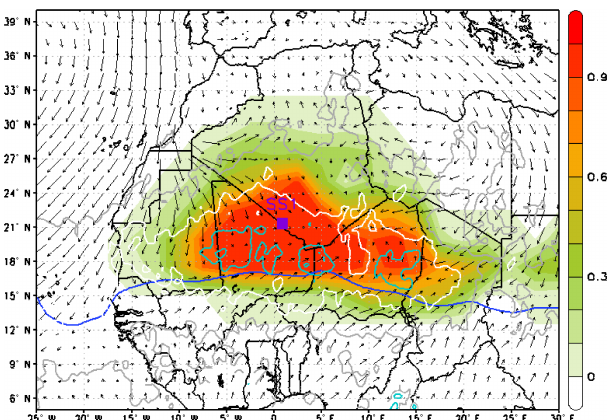
Figure 1. Climatological state of the Saharan heat low region (mean of June, 1979–2013): SHL location, low-level circulation, and dust load. Shaded: the mean position of heat low region (occurrence fre- quency of 90% of low-level atmospheric thickness); arrows: mean 925hPa wind; blue line: the mean position of the intertropical dis- continuity from ERA-Interim reanalysis data and aerosol optical depth (AOD) from Multi-angle Imaging Spectroradiometer (MISR) satellite data (contour intervals are 0.4, 0.6, and 0.8 for grey, white, and cyan lines). The purple rectangle denotes the location of the Fennec supersite 1